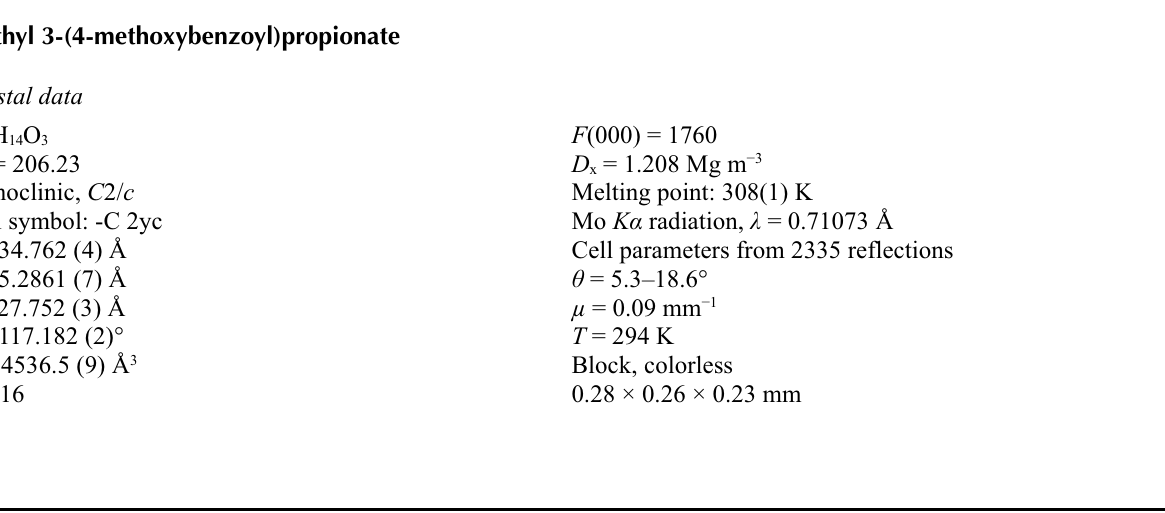
Figure 2 A partial packing diagram. Hydrogen bonds are shown as dashed